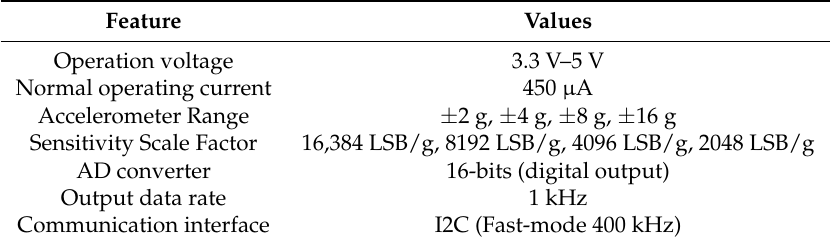
Table 3. Specifications of the triple-axis accelerometer in